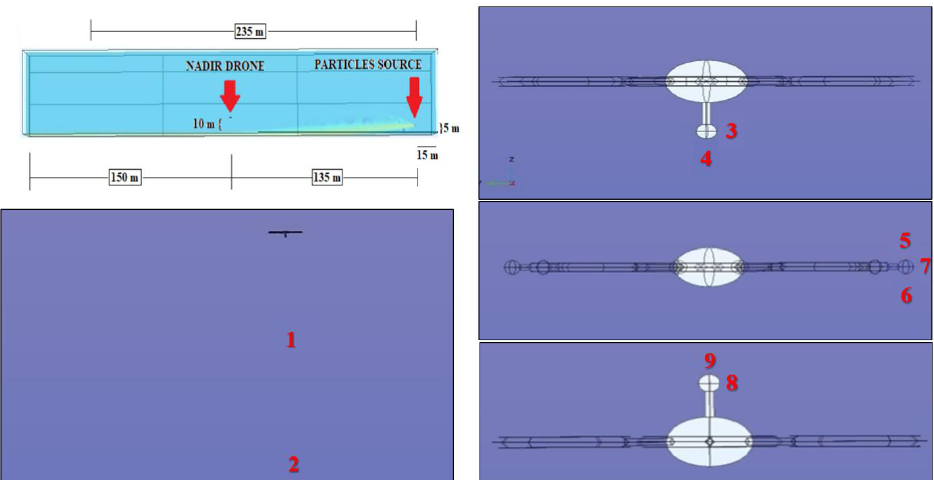
Figure 7. Schematics of the drone-sphere geometry, concentration field, and point analyzed in the numerical set 10-135-5.